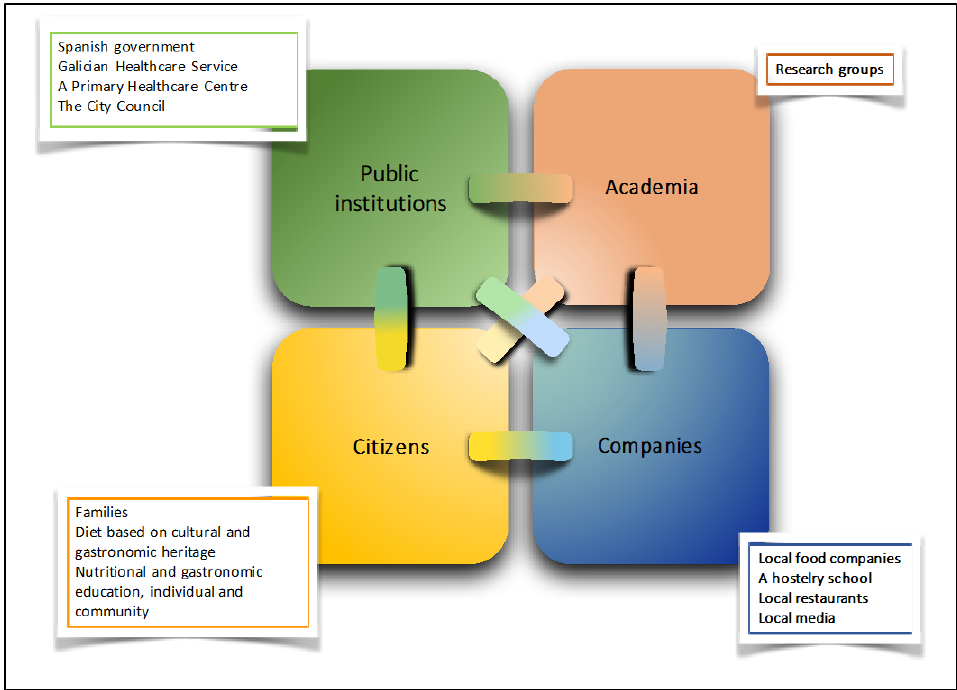
Figure 1. Quadruple-helix cooperation model involving four helixes: public institutions, researchers, businesses, and citizens.